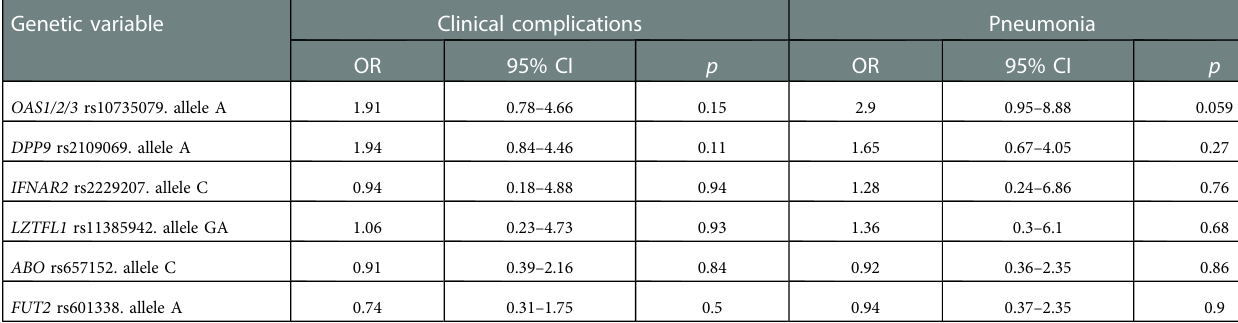
TABLE 4C Univariate logistic model of genetic factors associated with clinical complication or pneumonia development in children cohort. Genetic variable